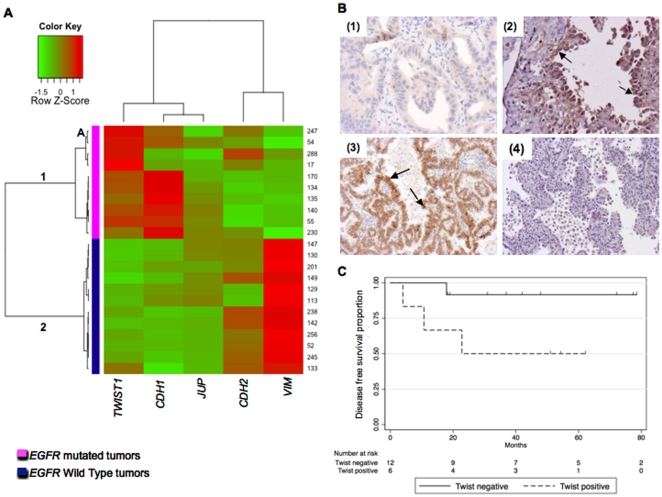
TWIST1 and CDH1 expression are inversely correlated in human lung primary tumors.
A.
TWIST1, CDH1, JUP, CDH2 and VIM expressions were assessed by quantitative RT-PCR in human lung primary tumors. Unsupervised hierarchical clustering isolated two groups. EGFR mutated tumors were classified in group 1 and EGFR wild type tumors in group 2. Group 1A, contains EGFR mutated TWIST1 reactivated tumors (247, 54, 17 and 288) with an intermediate phenotype (high TWIST1, low CDH1, low VIM expression) that could be undergoing an epithelial to mesenchymal transition. B. Representative microphotographs (20×) of immunohistochemical expression of CDH1 (1, 3) and TWIST1 (2, 4) in EGFR mutated tumors. Positive cells are indicated by arrows. Upper panels: example of tumor (sample 17), expressing a low amount of CDH1 (1) and TWIST1 (2). Lower panels: example of tumor (sample 18) expressing CDH1 (3) and lacking TWIST1 (4). C. Kaplan-Meier Disease free survival curves according to TWIST1 reactivation assessed by IHC on lung tumor tissue samples. Disease free survival is shortened in the TWIST1 positive group (p = 0.044).